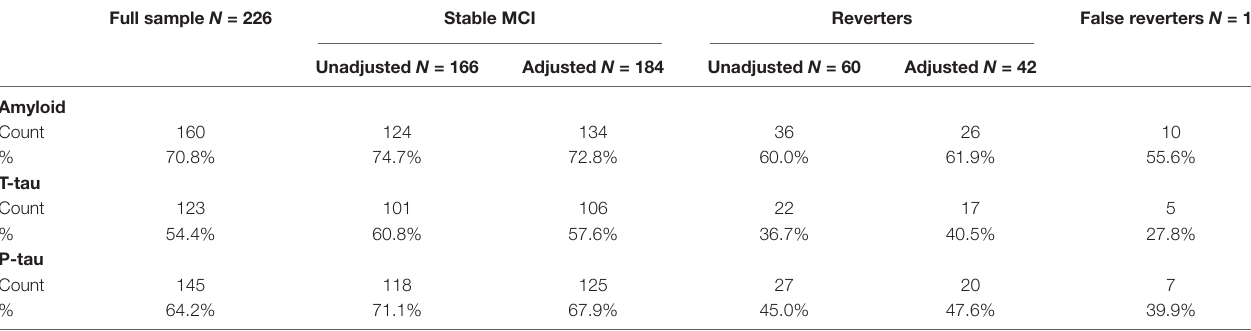
TABLE 6A | Amyloid, total tau, and phosphorylated tau across classification groups.